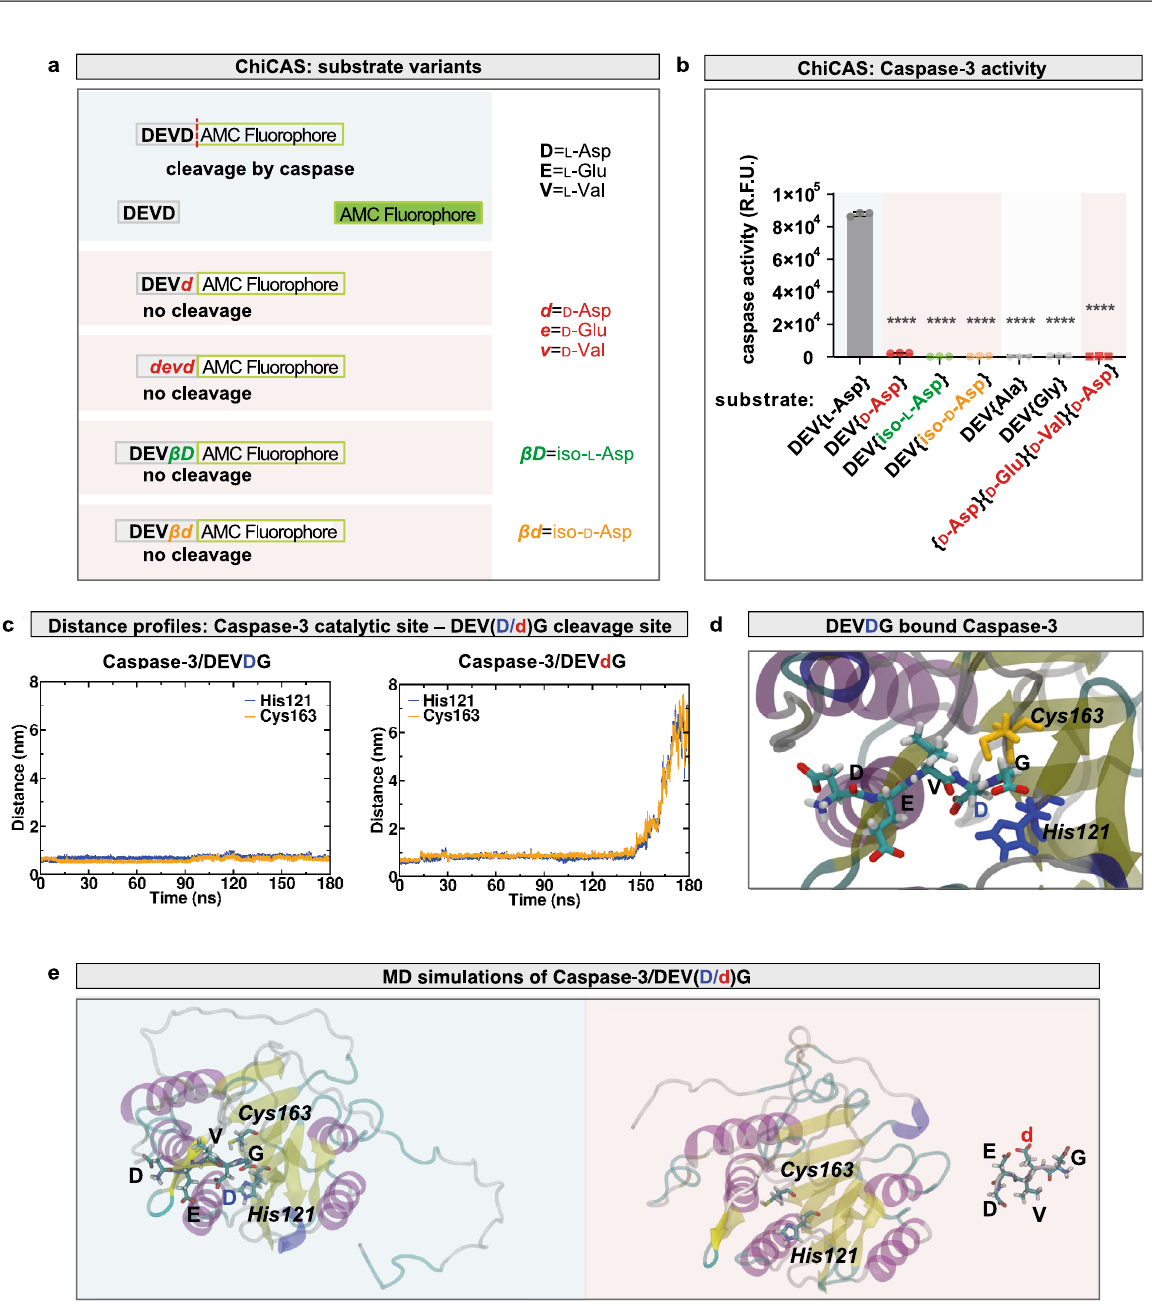
Fig. 3 | Heterochirality affects caspase-mediated cleavage of target proteins. Caspases are unable to cleave target sequences containing D -amino acid(s) as determined by chiral-speci fi c DEVDase assays. a In vitro chiral-speci fi c